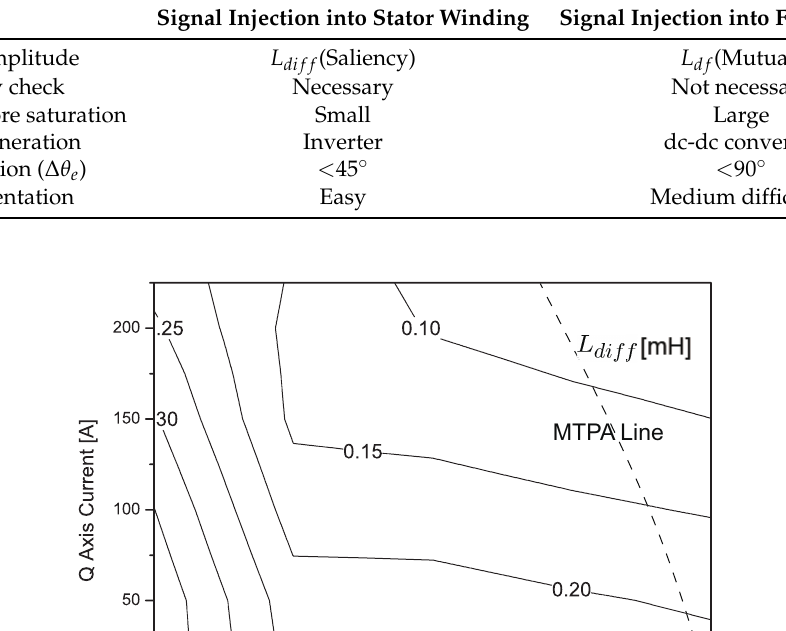
Table 2. Comparison between the injection methods into stator and field windings.